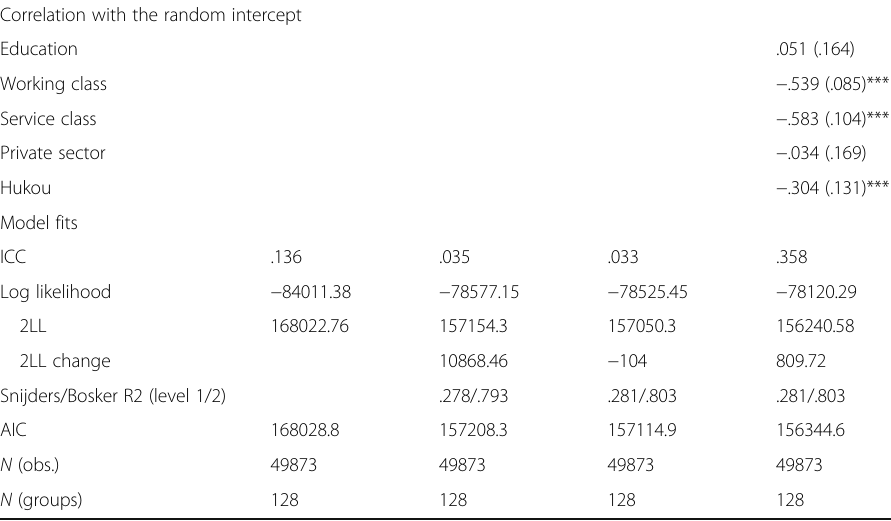
Table 3 Multilevel regression coefficients for individual and aggregated factors on log income